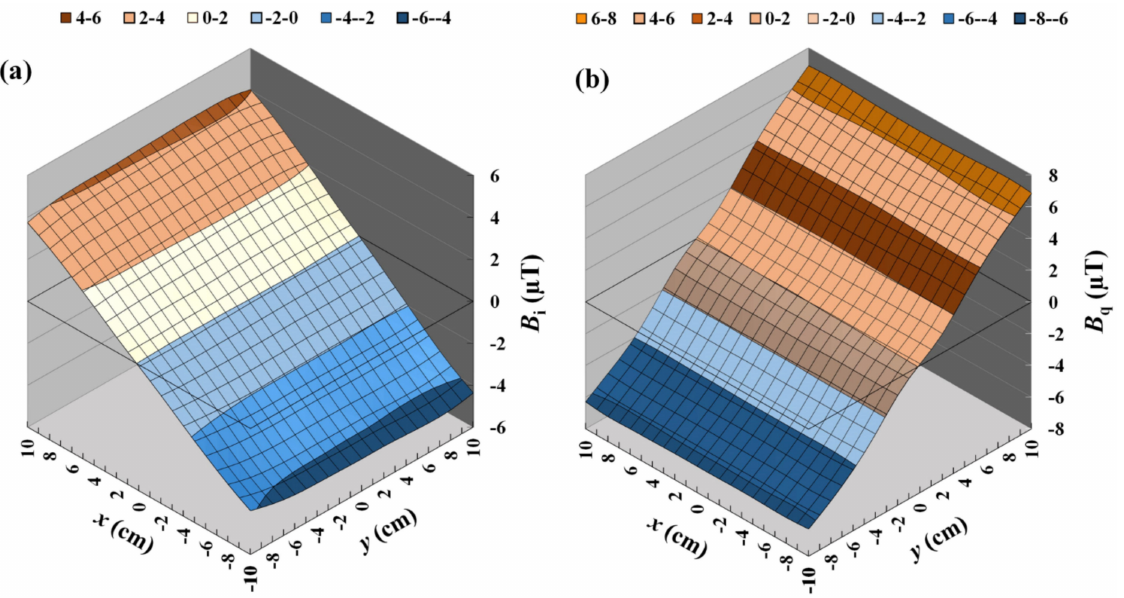
Figure 6. The measured field distributions of ( a ) x –coil ( B i ) and ( b ) y –coil ( B q ). The total number of field points is 11 × 11 = 121 and the grid size is 2 cm × 2 cm. A cubic spline interpolation was used to obtain the smooth distribution.